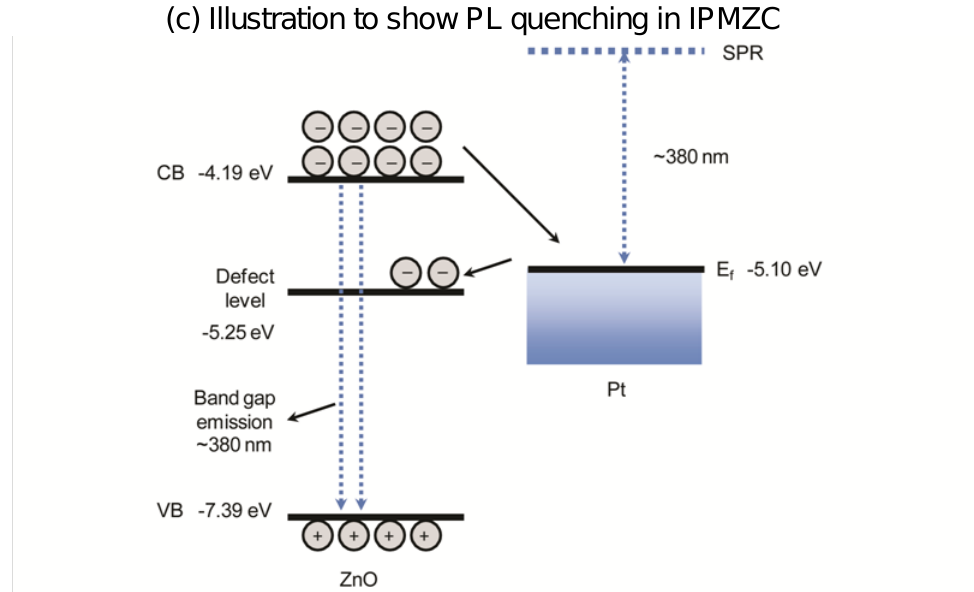
Figure 6. Cont. (c) Illustration to show PL quenching in